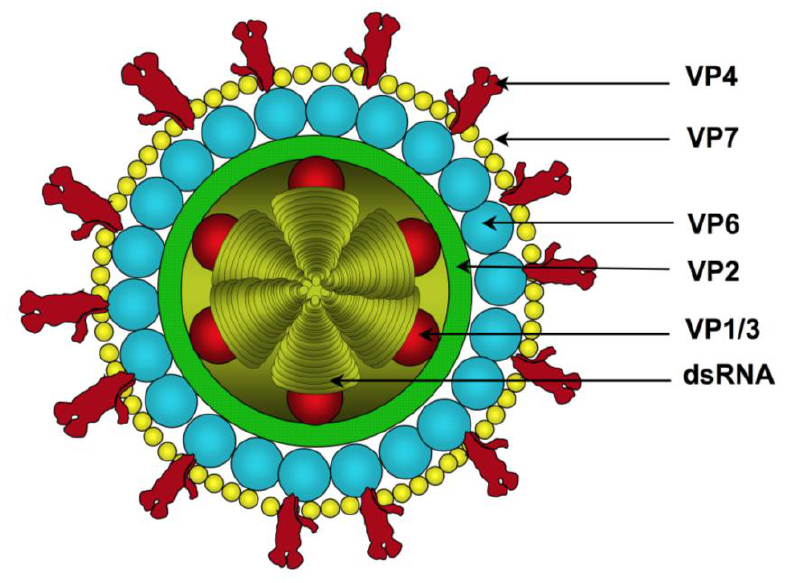
FIGURE 1 . Schematic depiction of the structure of mature rotavirus particle (TLP). The three concentric capsid protein layers are colored such that red represents VP4 spikes, yellow is the VP7 layer forming the outer layer, blue is the VP6 layer, and green is the VP2 layer. The dsRNA segments (brown) are packed inside the core associated to the RNA polymerase complex (VP1 and VP3, red balls). No inference to stoichiometry is